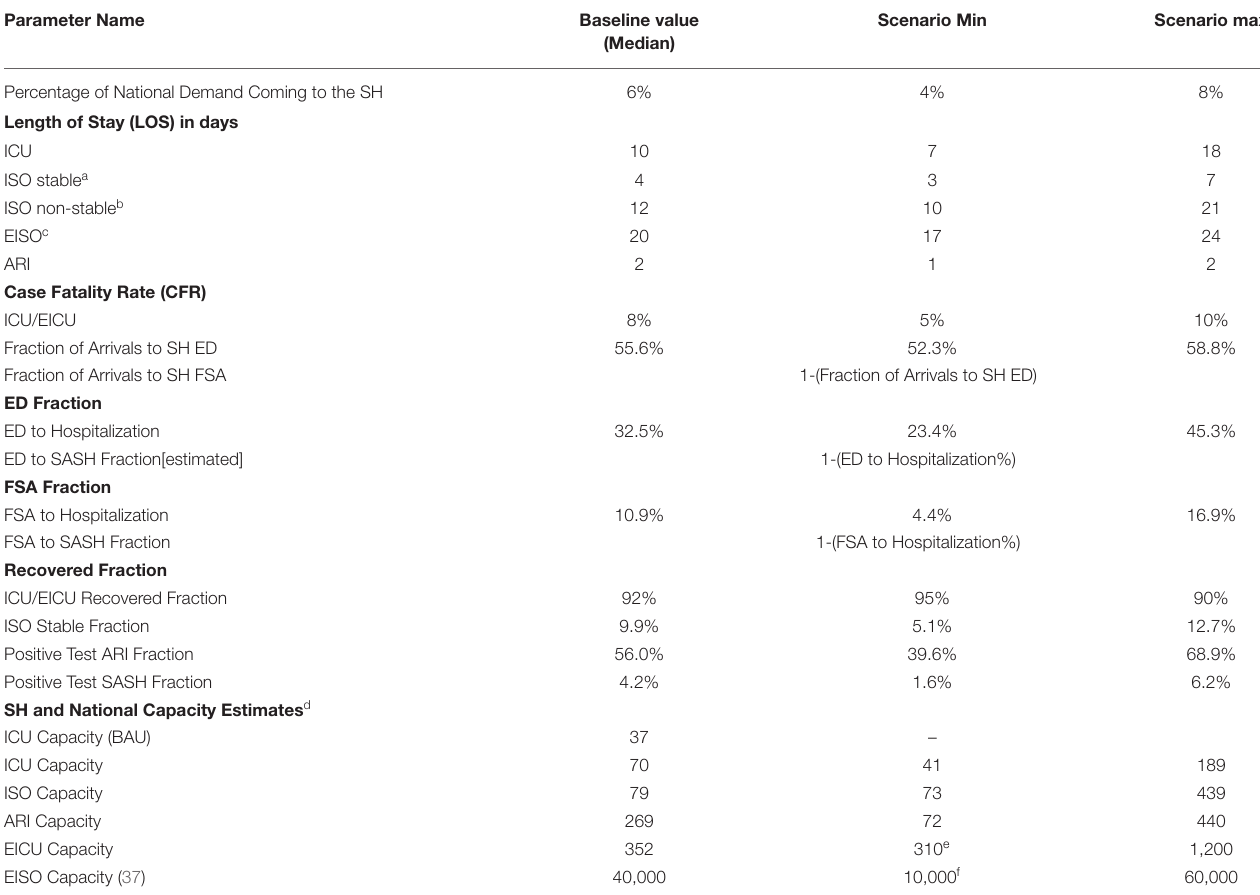
TABLE 1 | Key parameters for the